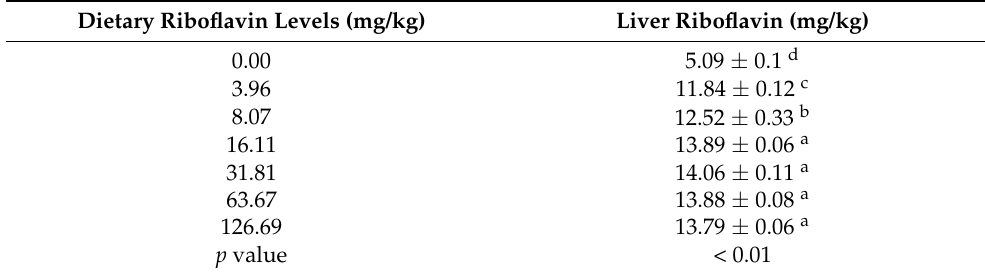
Table 4. Measures of the biochemical indicators of liver riboflavin status at the conclusion of the 12-week feeding